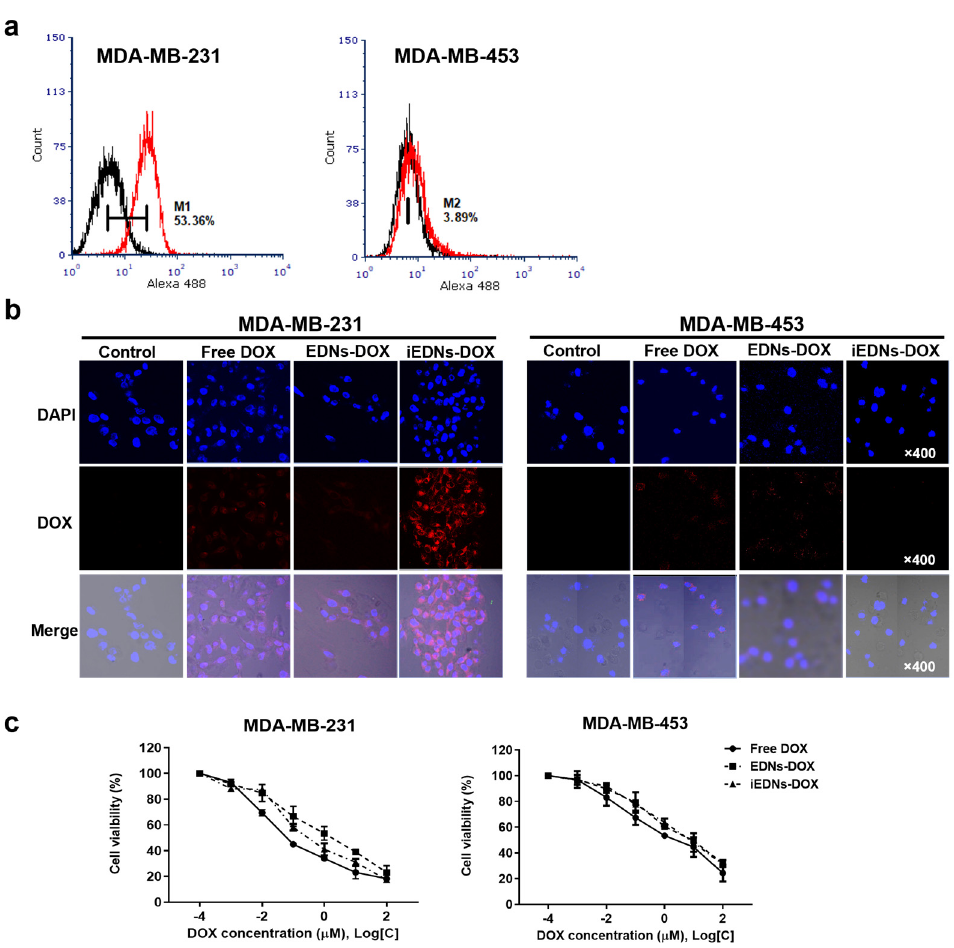
Figure 4. Tumor ‐ targeted intracellular drug delivery and anti ‐ cancer effects of iEDNs ‐ DOX. ( a